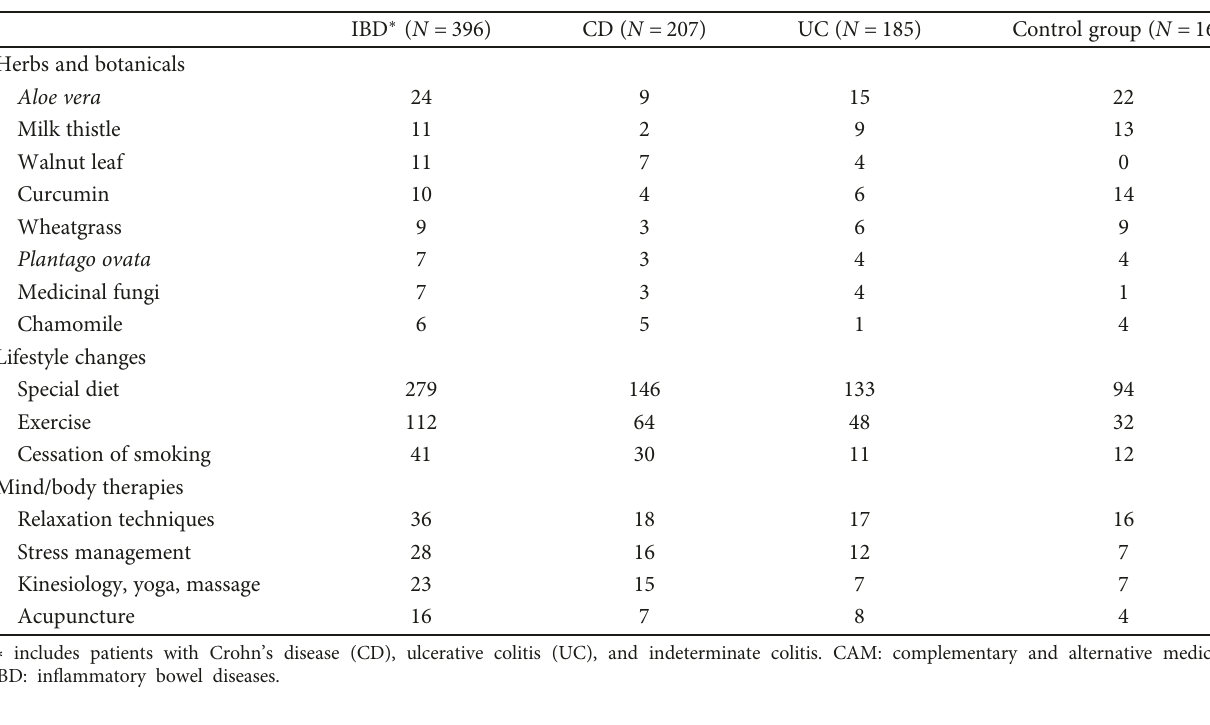
Table 1: The most preferred CAM types.